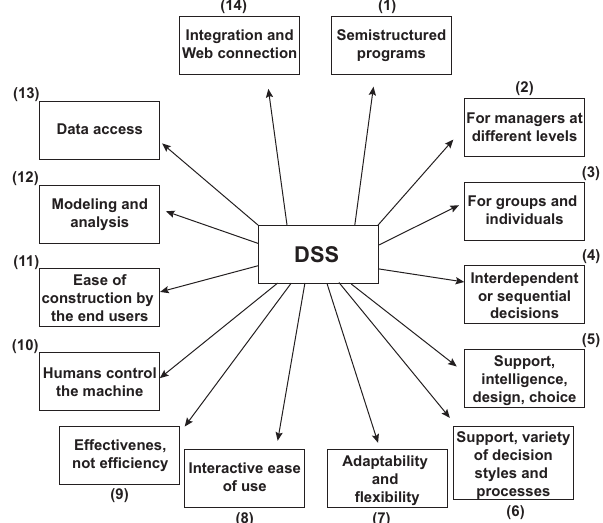
Figure 3. Key characteristics and capabilities of a DSS, adapted from [23].